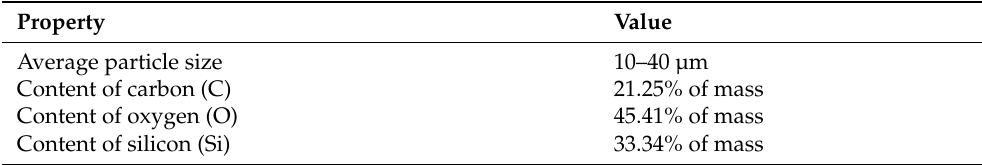
Table 3. Characteristics of SiO 2 extracted from rice husk.